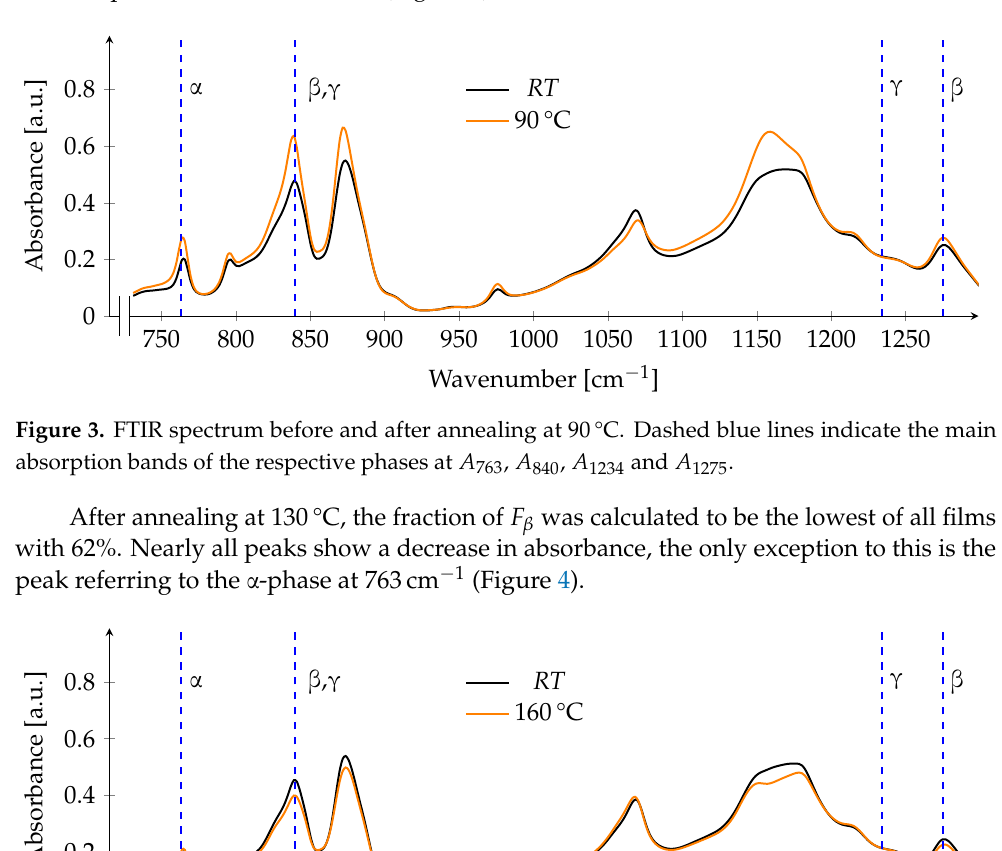
sorbance. The peaks indicating the β -phase at 840 and 1275 cm − 1 show a higher increase than the peak of the α -phase at 763 cm − 1 . The γ -phase is not present in the film, as there is no absorption band at 1234 cm − 1 (Figure 3).